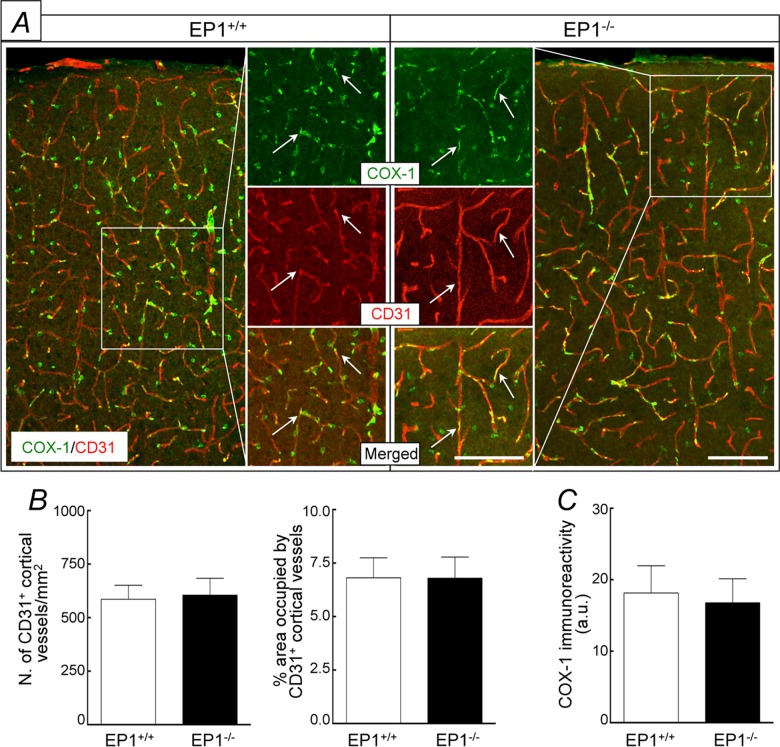
Blood vessel profiles and COX-1 expression in the somatosensory cortex of EP1+/+ and EP1-/- mice.A, COX-1 immunoreactivity (green) is co-localized with the endothelial cell marker CD31 (red) both in EP1+/+ and EP1-/- mice. B, number of CD31-positive neocortical blood vessels and % area occupied by the blood vessels do not differ between EP1+/+ and EP1-/- mice. C, quantification of COX-1 immunoreactivity is similar between EP1+/+ and EP1-/- mice. A.u., arbitrary unit; scale bar: 100 μm; n = 5/group.